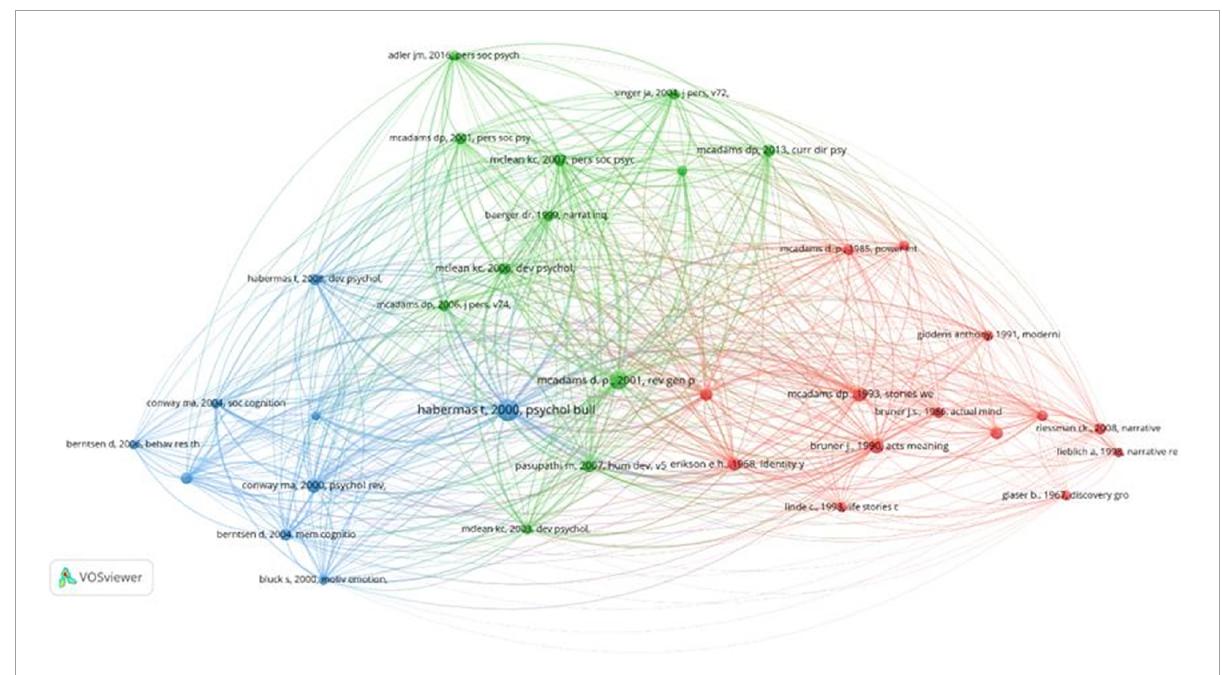
FIGURE5 Co-citation of